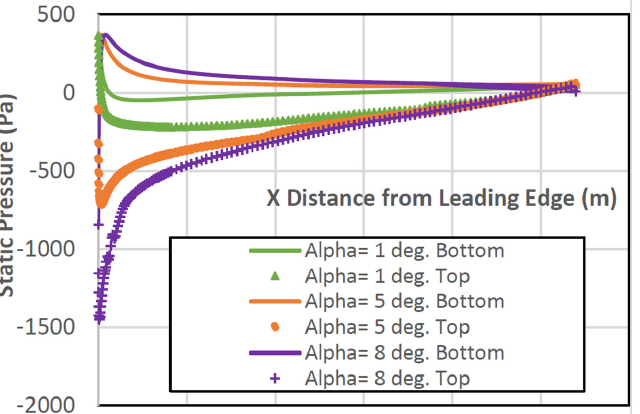
Figure 10. Pressure distribution around NACA2410 with varying AoA while x ticks from 0 with increment of 0.32; (0, 0.32, 0.64, 0.96, 1.28, 1.6, and 1.92, respectively).